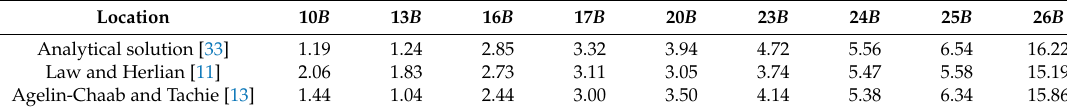
Table 3. MARE (%) values for U profiles in x - z plane at different locations ( z / z m/2 < 1.2).